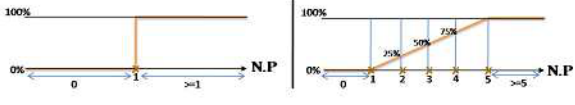
Fig. 9. (left) binary function. (right) fuzzy function.